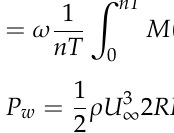
Figure 21. Moments produced by aerodynamic loads in X ‐ and Y ‐ directions along the Z ‐ direction on the ( a ) H ‐ type and ( c ) hybrid VAWTs and their dominant excitation frequencies for the ( b ) H ‐ type and ( d ) hybrid